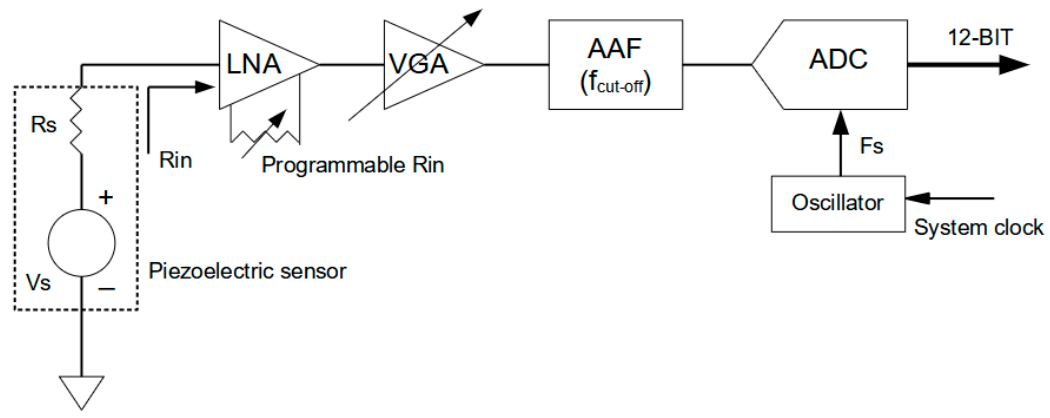
Figure 10. A wired sensor network based on autonomous sensor node design. In the example each node is equipped with ab ultrasonic transducer for active and passive ultrasonic guided waves (UGW) operation: ( a ) node electronic block scheme; ( b ) node rendering; and, ( c ) rendering of a possible application to a Composite Overwrapped Pressure Vessel Figure 11. Programmable single channel AFE for signal conditioning of piezoelectric sensor. (COPV) equipped with a wired sensor network.